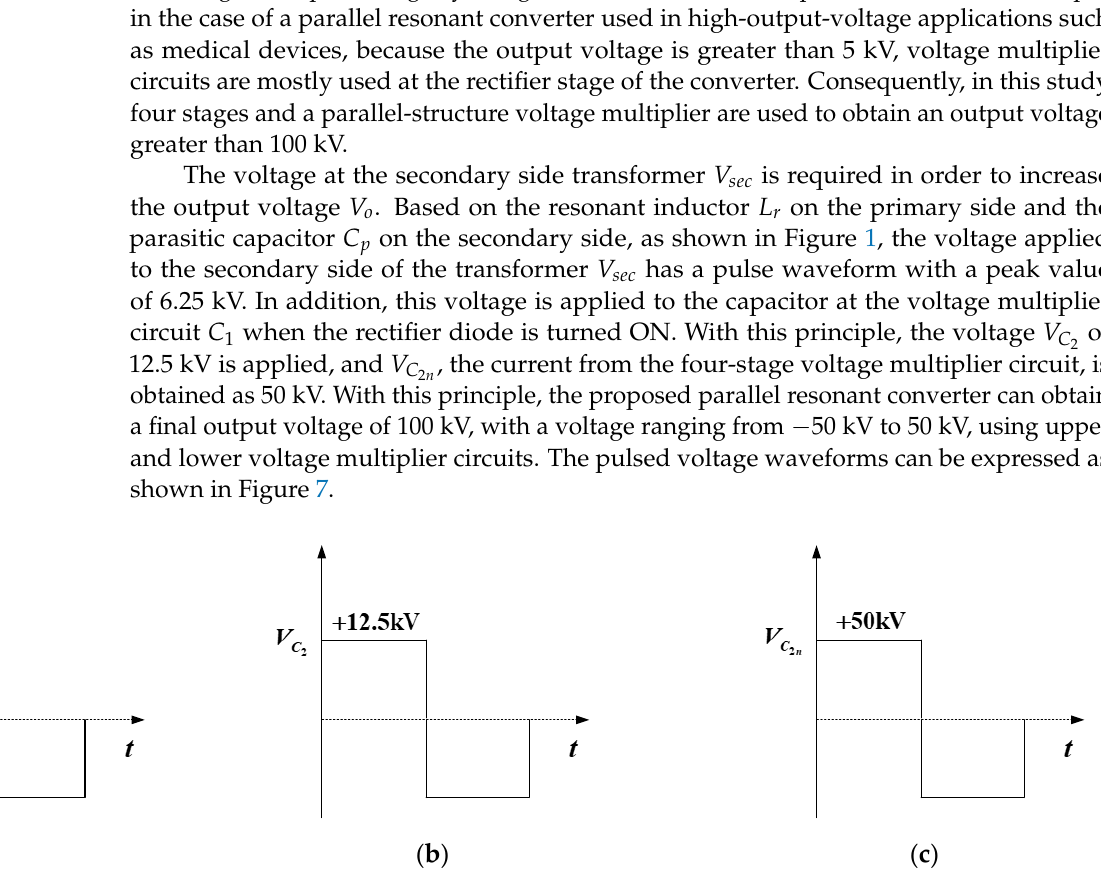
Figure 7. ( a ) Voltage at the secondary side of the transformer. ( b ) Voltage after 1st voltage multiplier. ( c ) Voltage after 4th voltage multiplier.